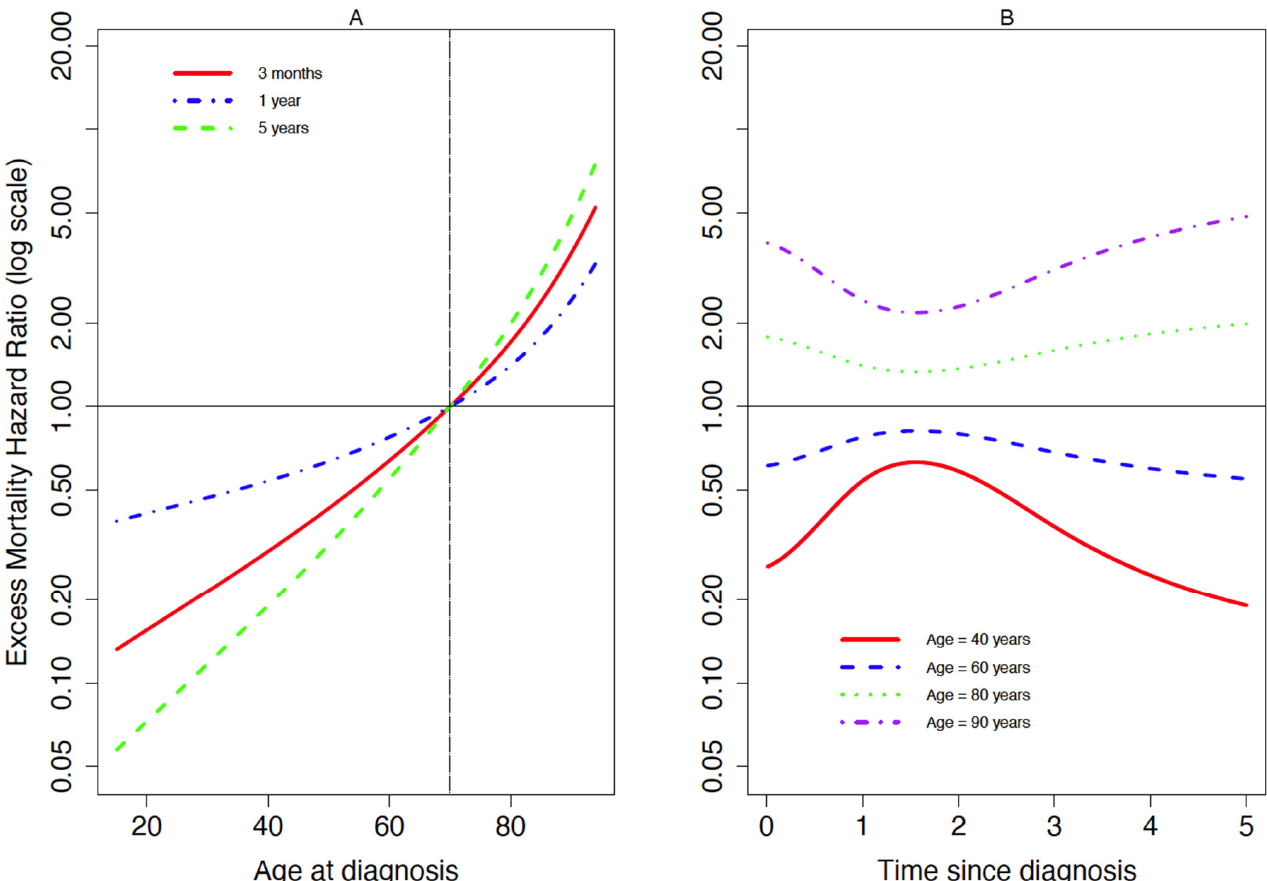
Figure 1. Excess mortality hazard ratios according to ( A ) age at diagnosis at different time since diagnosis (3 months, 1 and 5 years), and ( B ) time since diagnosis for different age groups, amongst patients diagnosed with diffuse large B-cell lymphoma ( n = 29,898) in England during 2005–2013.